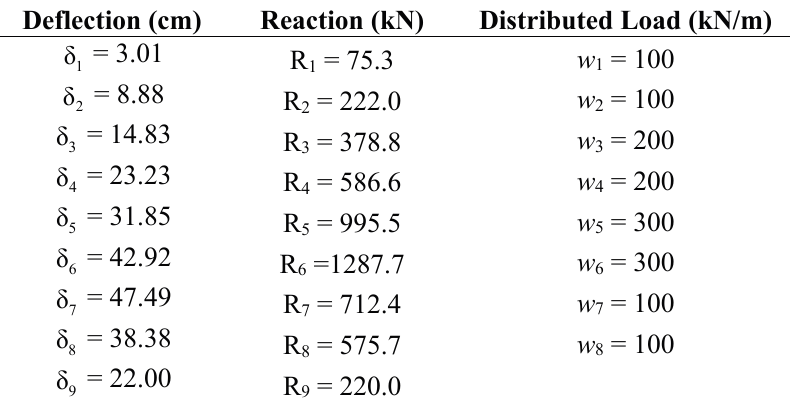
Table 3. Estimated deflections, reactions, and magnitudes of distributed loads for an eight-span beam. Deflection (cm) Reaction